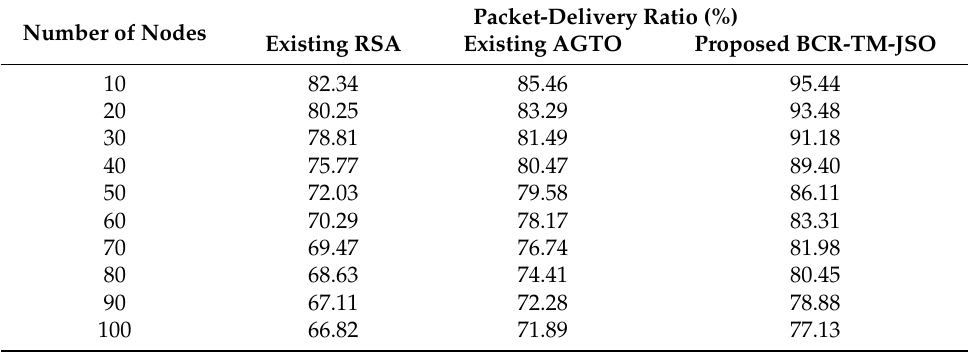
Table 2. Analysis of PDR with various optimization